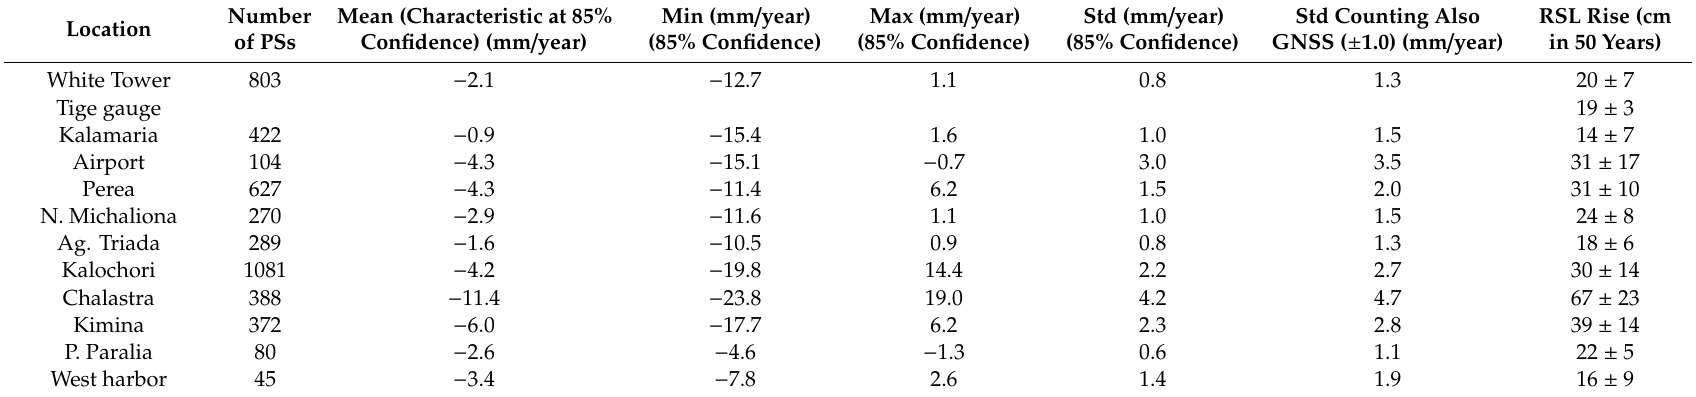
Table 4. Statistics of the sub-areas of the Thermaic Gulf; Thessaloniki, Axios Delta. Amongst others, the characteristic (mean) values of vertical deformation rate, the relative sea level rise, and the uncertainty are shown. PS stands for permanent scatterers; GNSS for Global Navigation Satellite System; RSL for relative sea level. Location